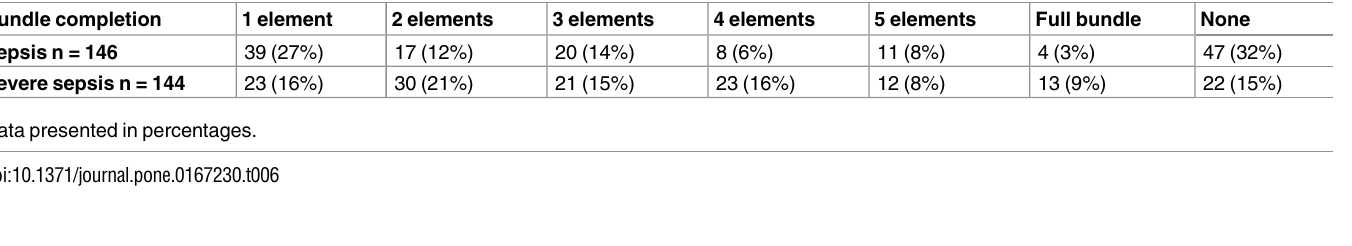
Table 6. Sepsis 6 bundle completion in sepsis and severesepsis patients by number of elements Bundle